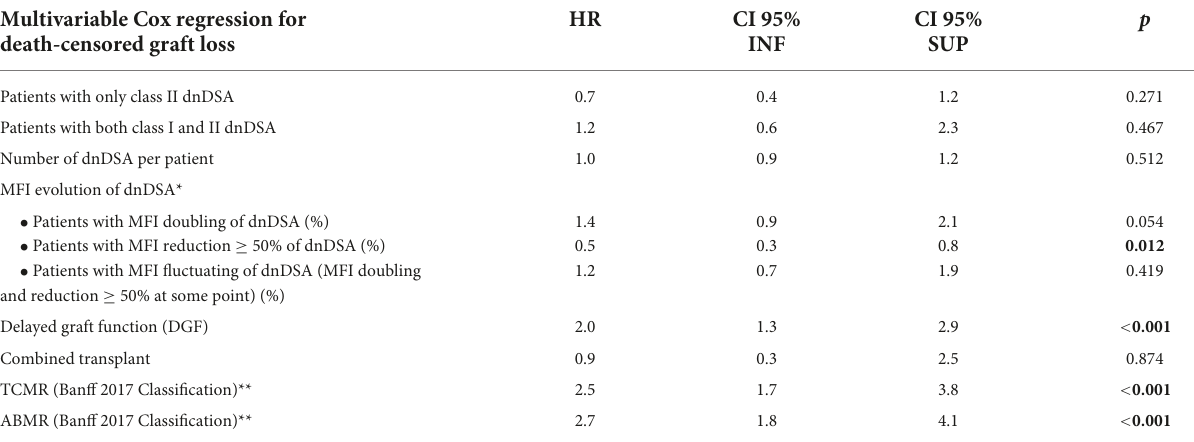
TABLE 7 Multivariable Cox regression analysis for death-censored graft loss. Multivariable Cox regression for death-censored graft